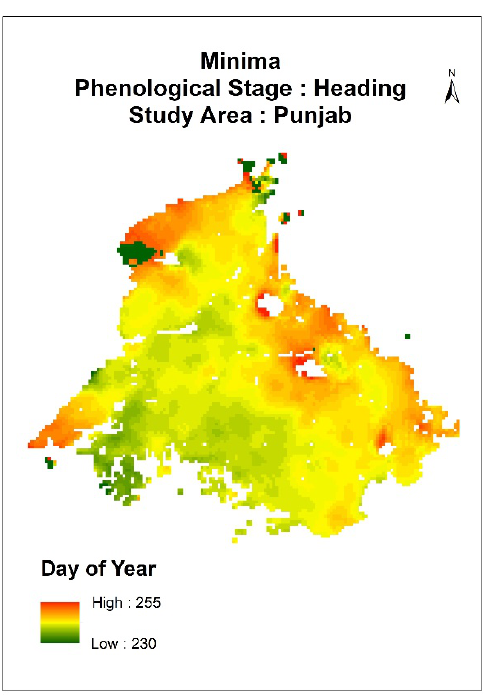
Figure 5: Heading stage of Rice for Punjab derived from ScatSat Data